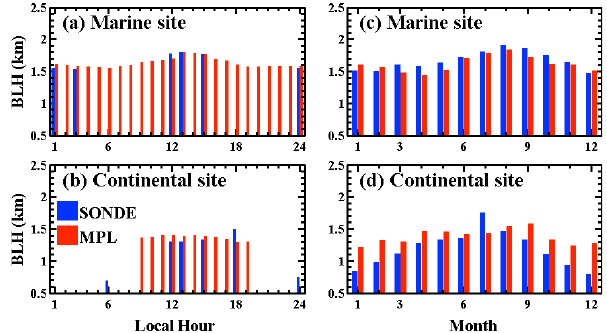
Figure 7. Diurnal cycles of BLH at the marine site (a) and the continental site (b) ; and annual cycles of BLH at the Fig. 7. Diurnal cycles of BLH at the marine site (a) and the conti- marine site (c) and the continental site (d) . nental site (b) ; and annual cycles of BLH at the marine site (c) and The lidar-based algorithms discussed above are applied to MPL observations at the continental site (d) marine site (2007-2008, daytime and nighttime, 10194 profiles) and continental site (2007-2009, daytime only, 5438 profiles). 3-hour averaged BLH were collocated with SONDE observations for comparison, as shown in figure 6 (a) and (b). MPL derived BLHs show good agreements SONDE determined BLHs. Over ocean, the bias and mean square error (MSE) of MPL derived BLH is -0.12 ± 0.24 km, and 83% of points have a percentage difference less than 30%. Over land, the bias and MSE is -0.04 ± 0.27 km. 74% of points have a percentage difference less than 30%. Over land (Fig. 6b), unidentified elevated aerosol layers result in a few points with MPL derived BLH much higher than SONDE derived BLH. Under strong convection situation over land, the gradient method often